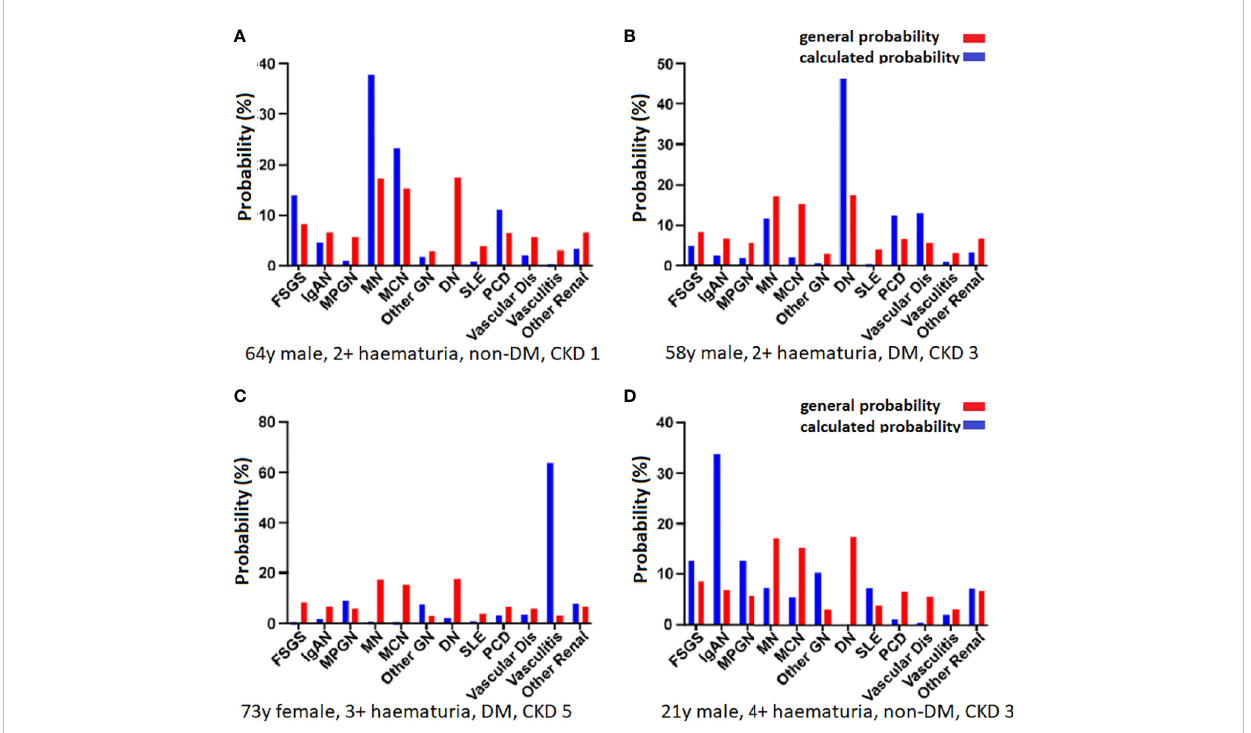
FIGURE 2 Calculated probabilities for four patients. The red bars indicate the overall probability without entering any speci fi c patient data and the blue bars show the calculated probabilities. The parameters were age, sex, diabetes status, hematuria, and CKD stage. (A) In a 64-year-old man with 2+ hematuria, no known diabetes, and CKD stage 1, the most likely diagnosis is MN (38%), followed by MCN (23%) and FSGS (14%). (B) In a 58-year-old man with 2+ hematuria, known diabetes, and CKD stage 3, the most likely diagnosis is DN (47%), followed by vascular disease (13%), PCD (13%), and MN (12%). (C) In a 73-year-old woman with 3+ hematuria, known diabetes, and CKD stage 5, there is a very high probability of vasculitis (64%), and a lower risk of MPGN (9%), and other renal disease (8%). (D) A 21-year-old man with 4+ hematuria, no known diabetes, and CKD stage 3 is most likely to have a diagnosis of IgAN (34%), followed by MPGN and FSGS (13%